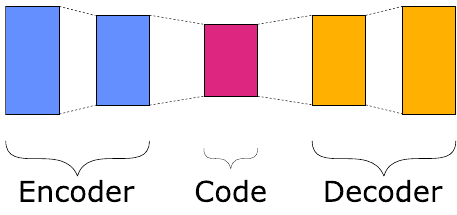
Fig. 6 Example architecture for autoencoders. Schematic illustra- tion of an autoencoder. Each bar represents a dense layer, bars of same size indicate same number of neurons in the respective